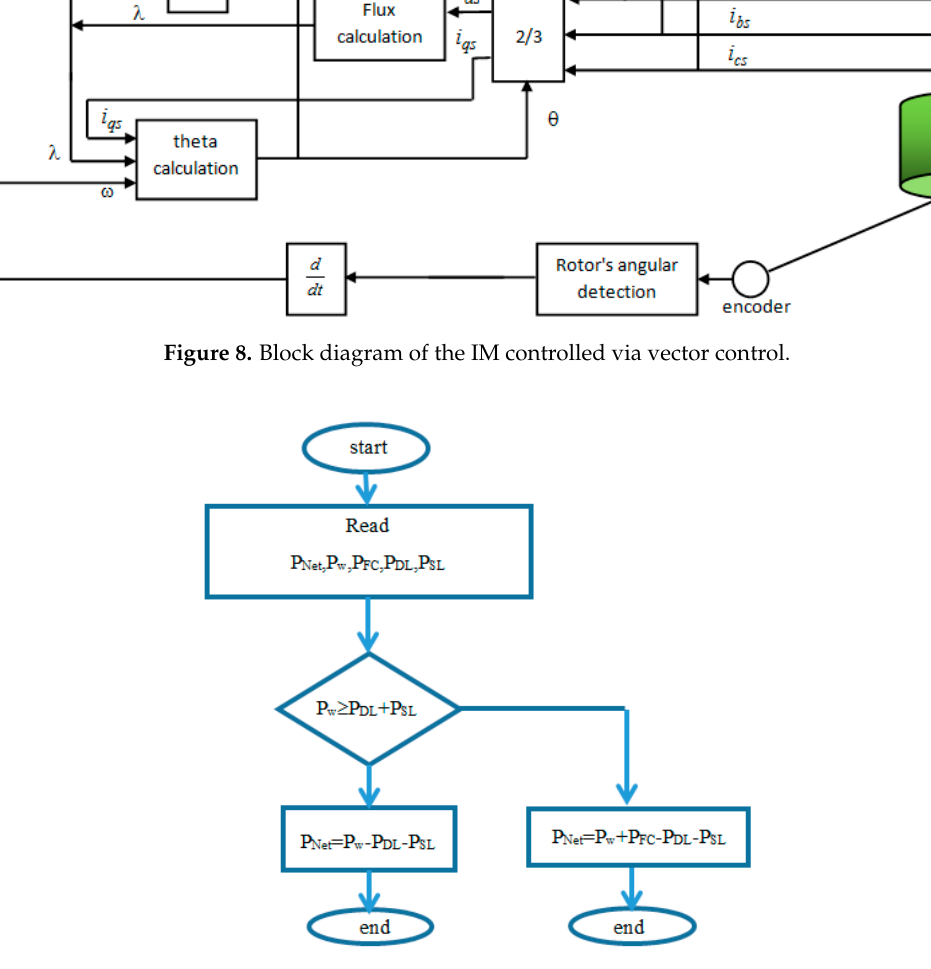
Figure 9. The flowchart of the power exchange strategy in the proposed autonomous microgrid.